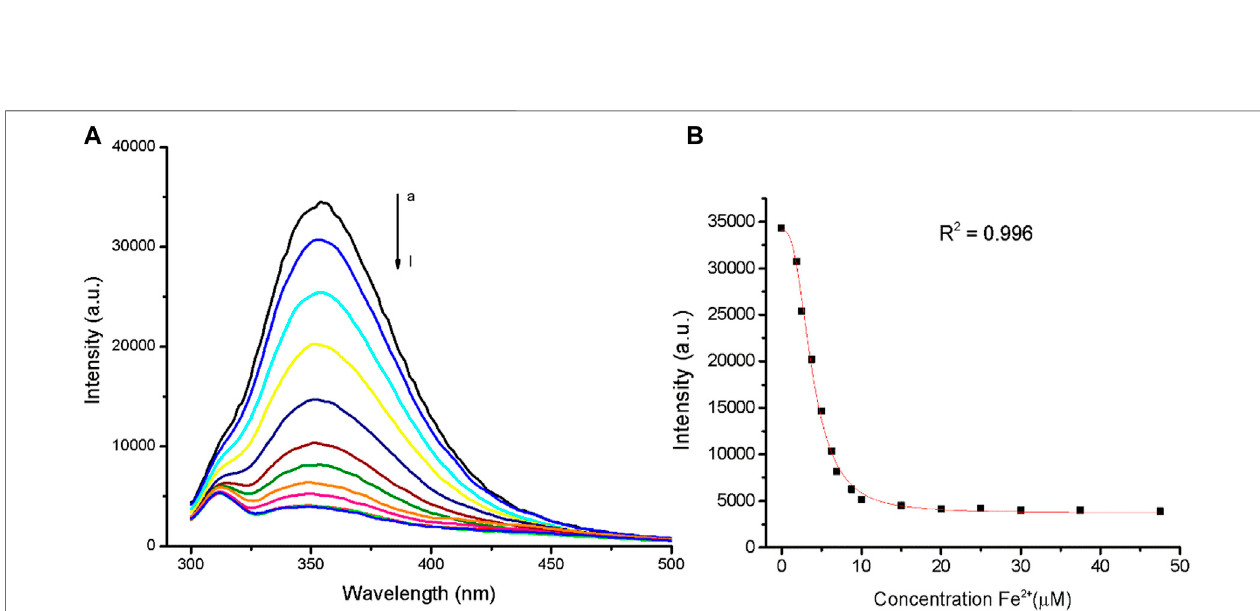
Frontiers in Molecular Biosciences |